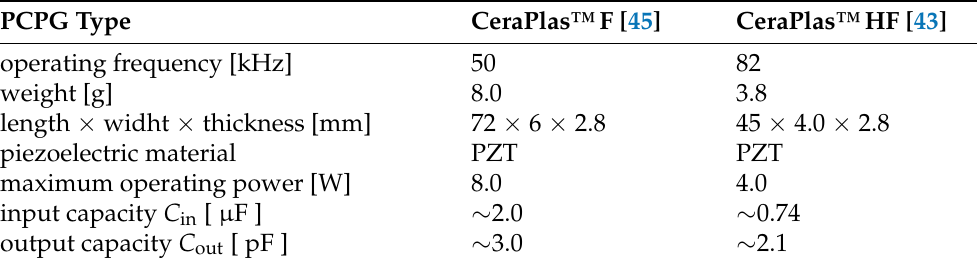
Table 1. The typical parameter of two